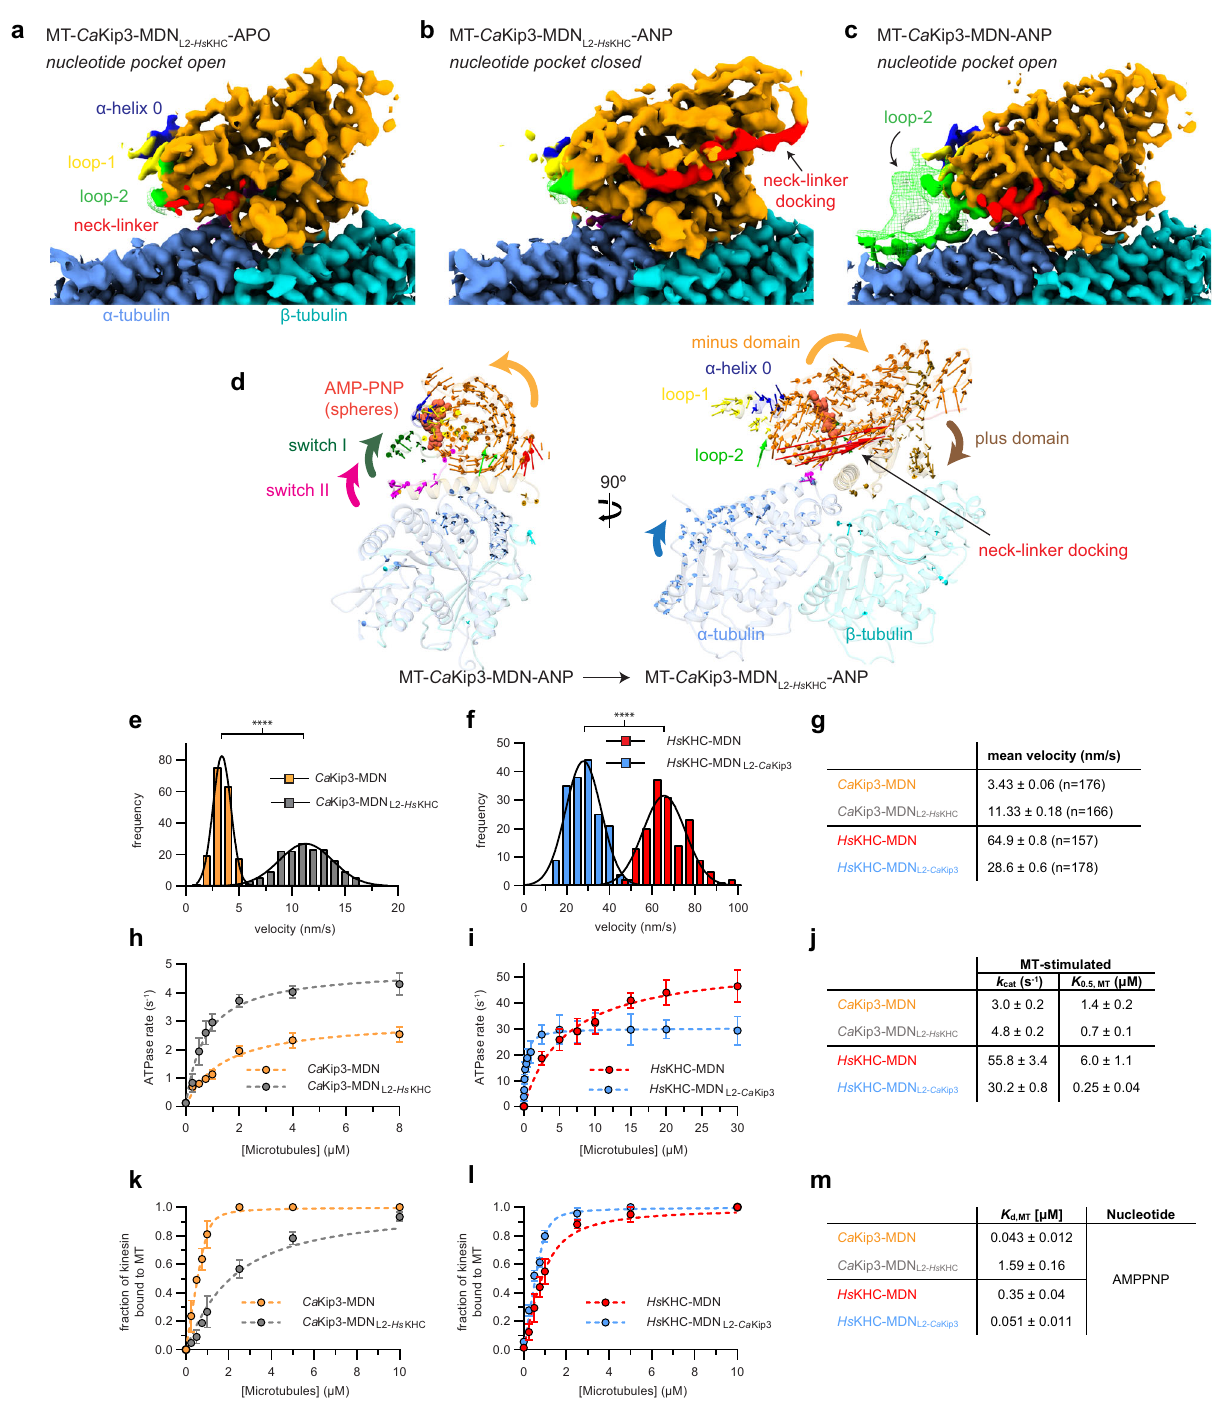
tubulin polymers. Our fi ndings demonstrate that, when kinesin-8 preceding motor domain. By maintaining loop-2 contacts with encounters curved tubulin proto fi laments, or proto fi laments that tubulin, and the loop-1 linkage between motors, the conforma- can become curved, which are found at the microtubule plus-end, tional transition of multiple motor domains to a closed con- its motor domain readily forms a pro-depolymerization formation could increase tubulin proto fi lament curvature enough state (Fig. 7). In this state, the elongated loop-2 region moves to trigger microtubule depolymerization. Alternatively, when toward the motor core to accommodate the position of α -tubulin kinesin-8 binds tubulin proto fi laments that are constrained to a in curved αβ -tubulin subunits. This displacement of loop-2 is straight conformation by the lateral proto fi lament interactions of accompanied by closing of the ATP pocket to form a nucleotide- the microtubule lattice, the interactions between loop-2 and α - hydrolysis-competent active site and a docked neck-linker. In tubulin restrict the motor domain from transitioning to the closed addition, loop-1 becomes more structurally ordered and inserts conformation with a docked neck-linker. Unable to stably interact into the deep groove between loop-8 and the core β -sheet of the with the preceding motor via loop-1, or to curve tubulin enough NATURE COMMUNICATIONS| (2022) 13:4198